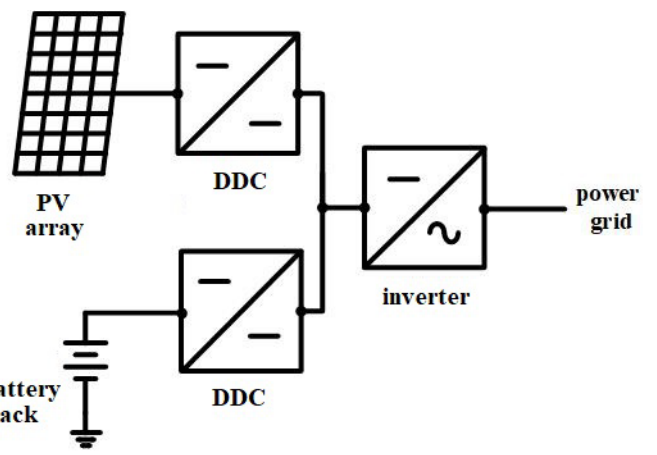
Figure 1. Power structure of the conventional PPGS with battery energy storage system.